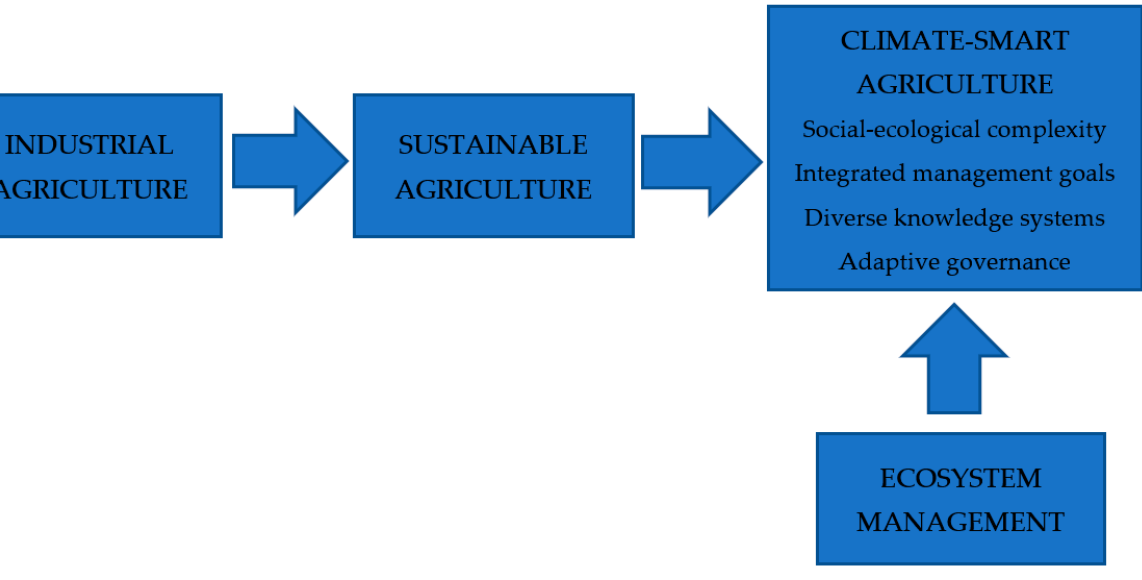
Figure 1. Ecosystem management and climate-smart agriculture.